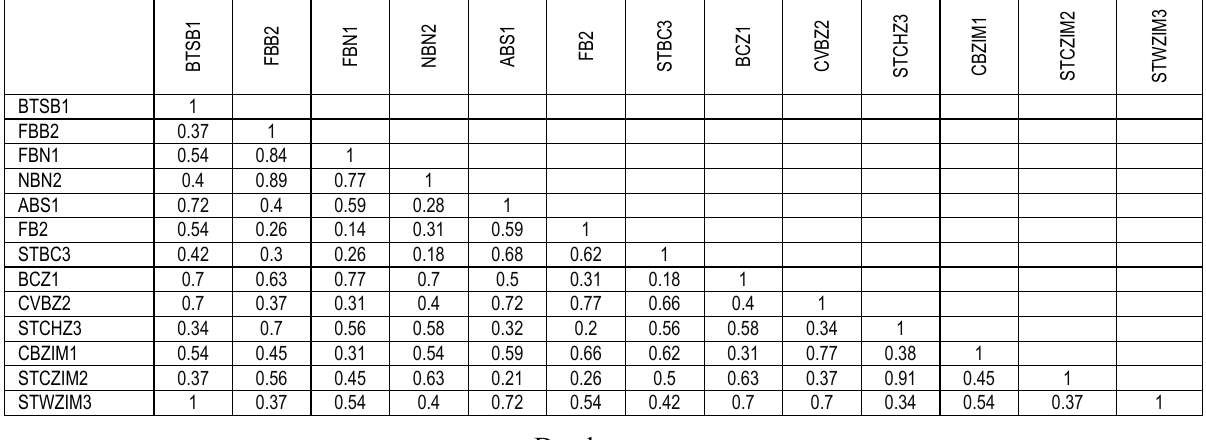
Table 2. Internet banking fraud awareness - similarity matrix